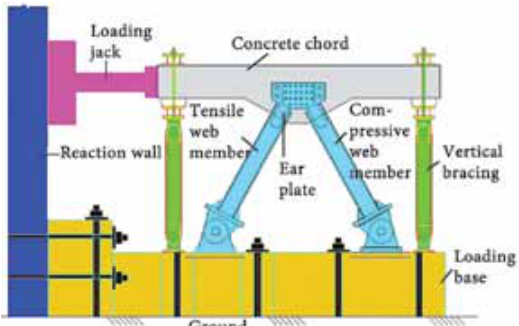
Fig. 4. Test loading device and specimen platea)